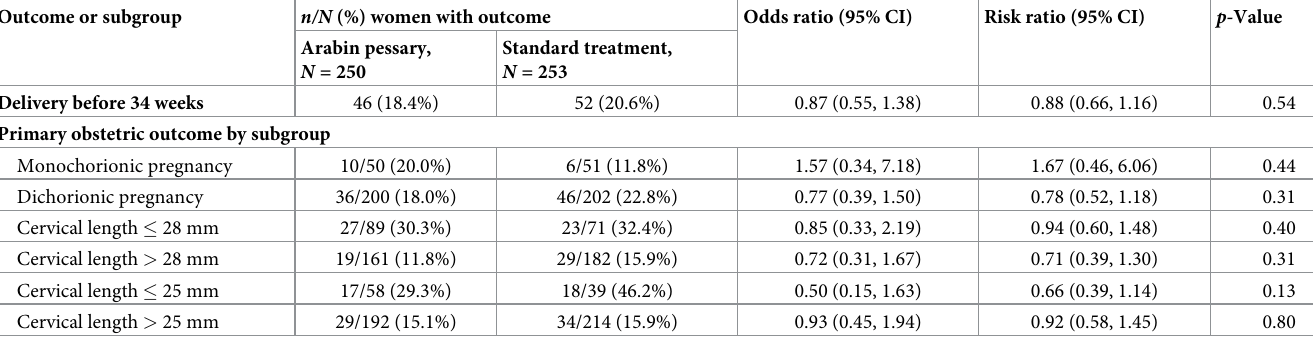
Table 2 AU : PleasecheckthattheeditstothecolumnheadsforTables 2 ; 3 ; 5 ; 6 ; and 7 correctlydescribethecontentsofeachcolumn : Ifnot ; pleaseprovidecorrectwording : . Primary obstetric outcome and key subgroup analyses. Outcome or subgroup